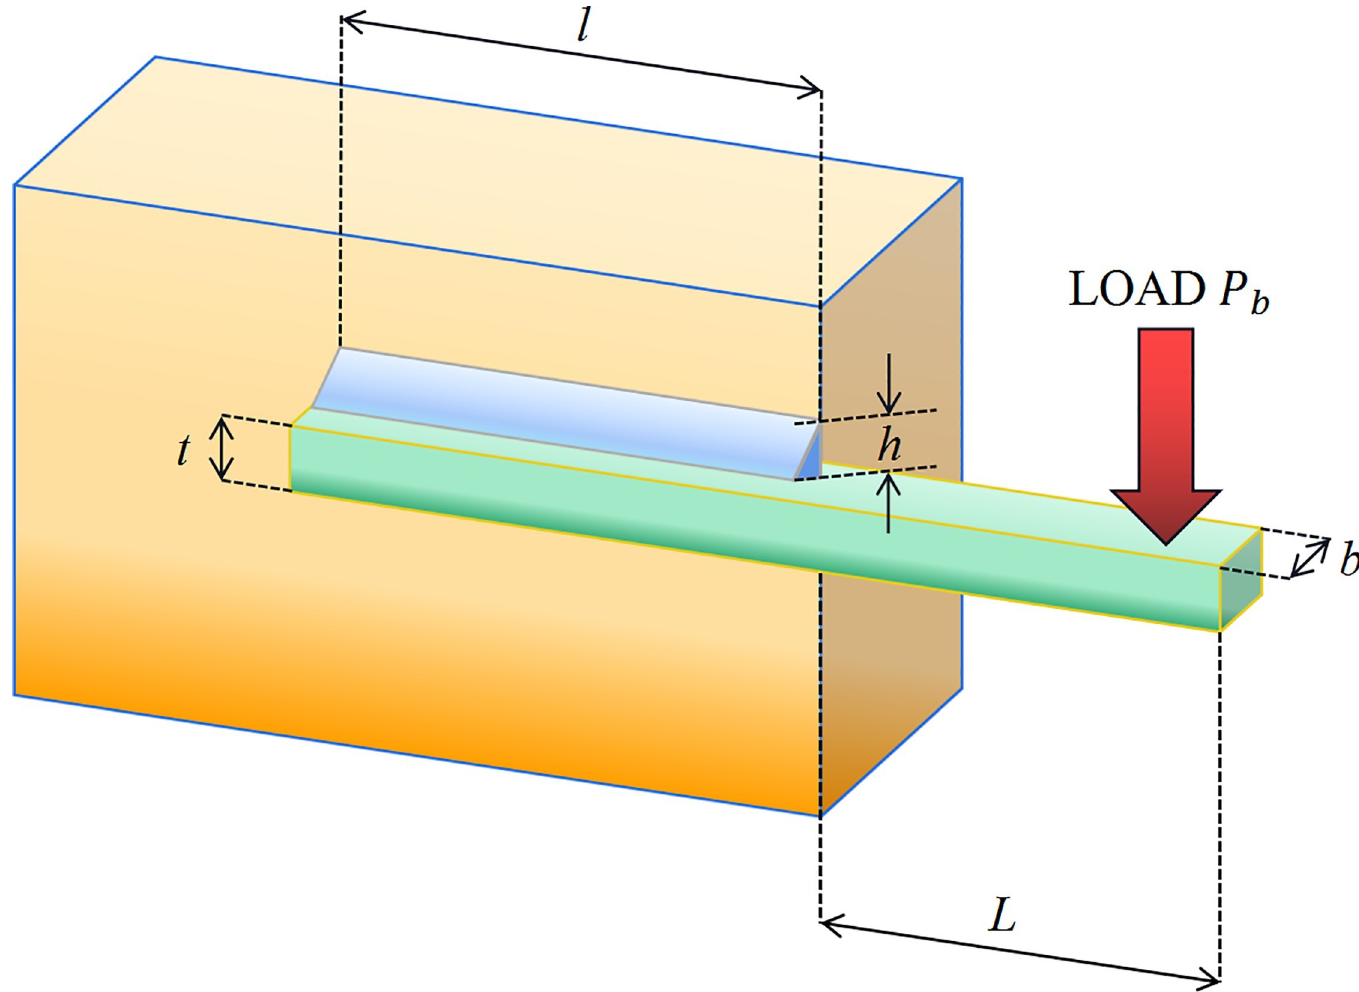
Fig 14. 3D schematic view of the welded beam design